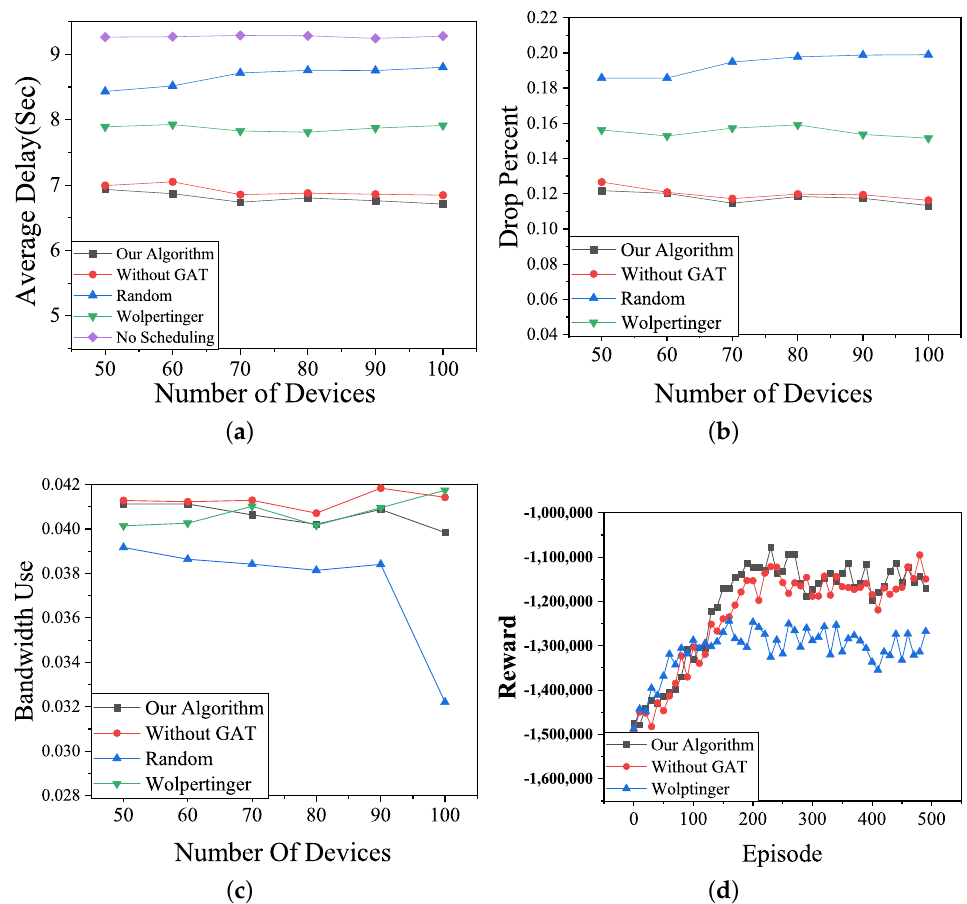
Figure 5. Multi-task scheduling simulation results over 500 episodes. ( a ) Delay; ( b ) Drop; ( c ) Band- width; ( d )